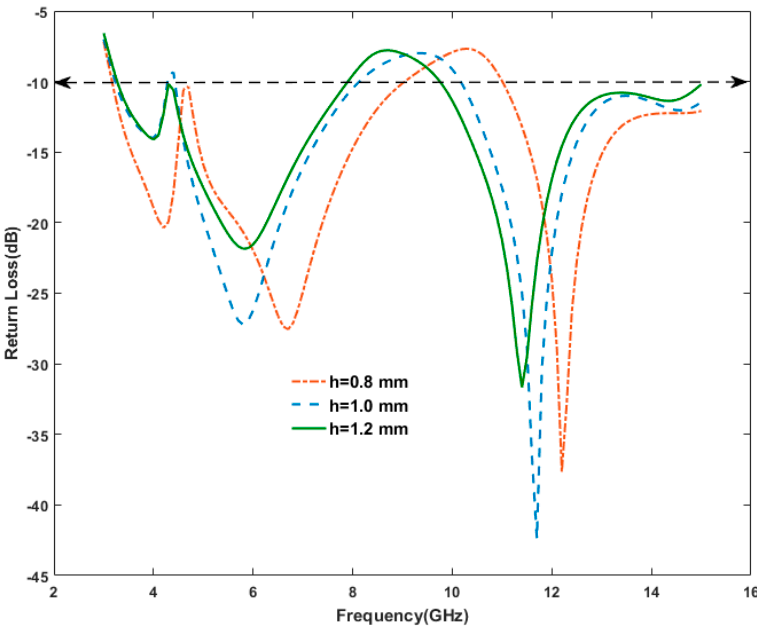
Figure 5. Study of variation on substrate height of textile antenna on the basis of return loss plot.